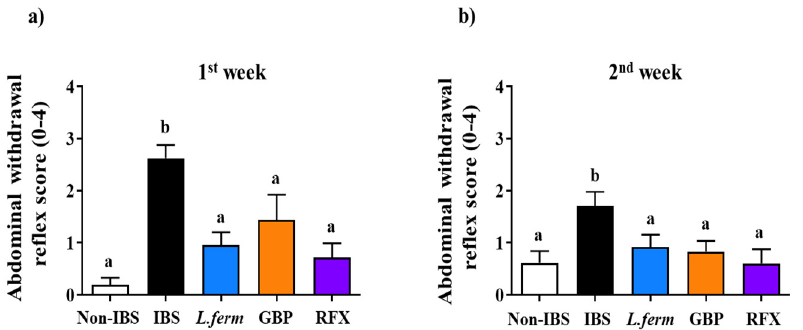
Figure 2. Response to colorectal distension (CRD) was collected using a score system; one ( a ) and two ( b ) weeks after intracolonic administration of DCA vehicle (Non-IBS), 4 mmol/L DCA (IBS), L. fermentum (10 9 CFU) ( L. ferm ), Gabapentin at 70 mg/kg (GBP) and Rifaximin at 150 mg/kg (RFX) treated rats. Data are expressed as means (triplicate measurements) ± SEM ( n = 10). Groups with different letters statistically differ ( p <